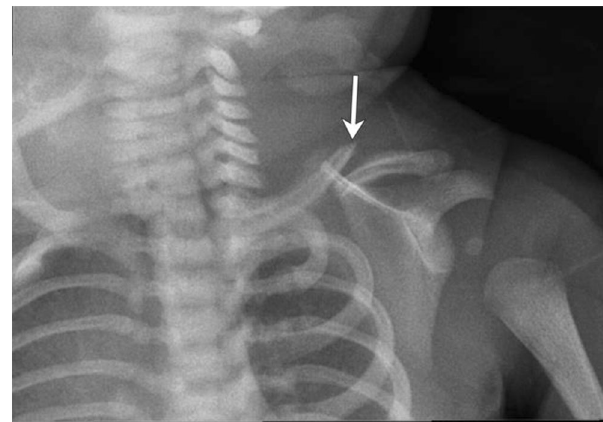
Fig. 16 Clavicle fracture, shoulder dystocia Macrosomic infant of diabetic mother presented with mildly displaced fracture of the left clavicle after a delivery complicated by shoulder dystocia. Patient also had neonatal brachial plexus palsy from which he